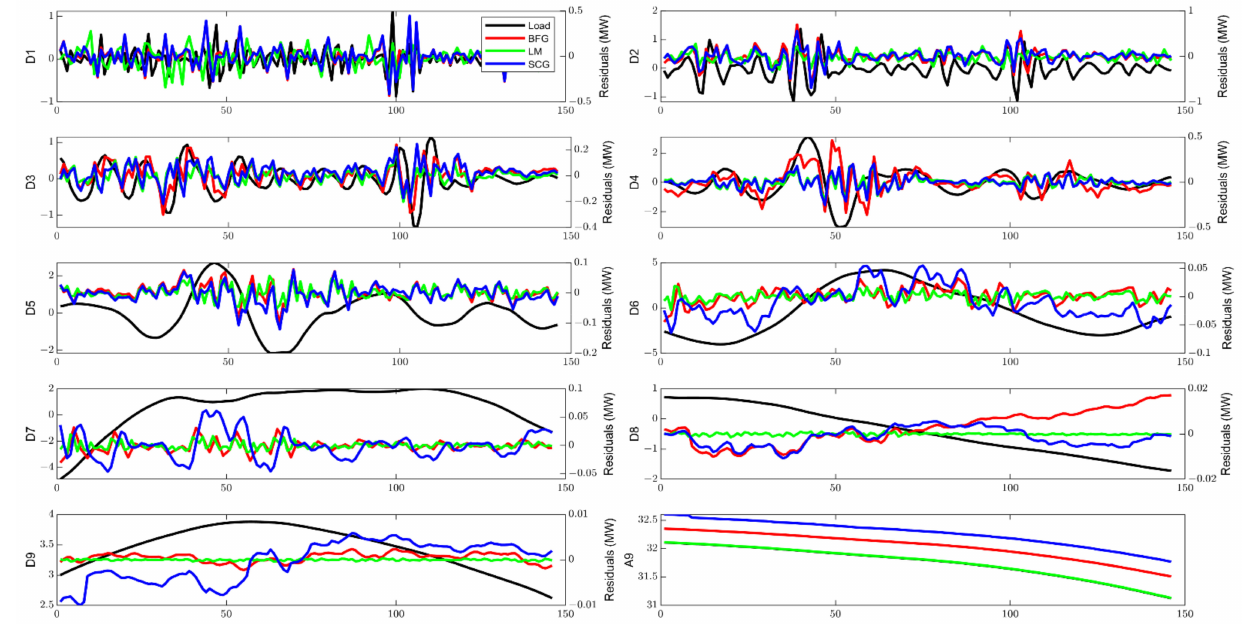
Figure 9. Residuals vs. real load of decomposed series.